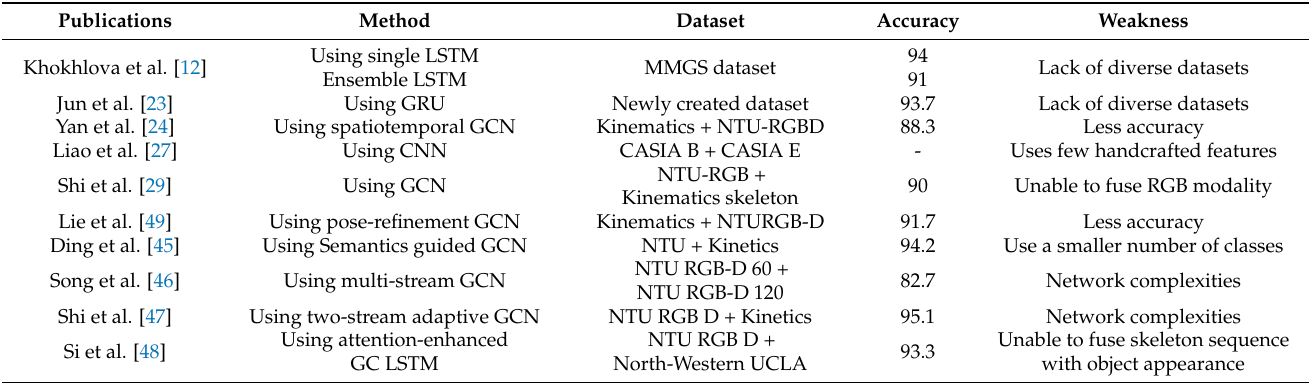
Table 1. Comparison and weaknesses of related